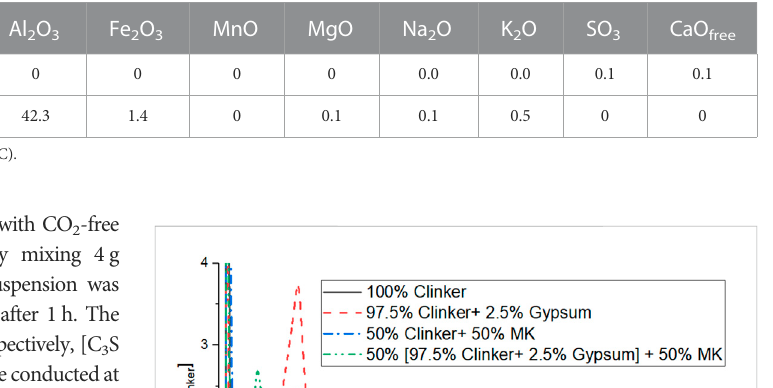
TABLE 1 Chemical composition of C 3 S and MK [mass-%].